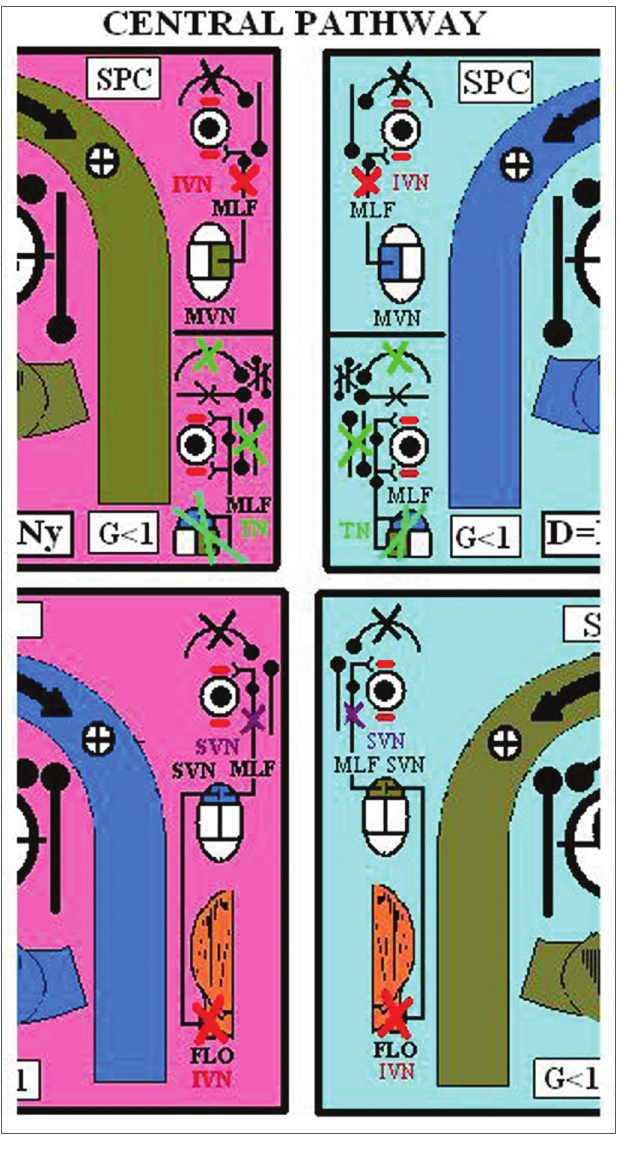
Figure 4. Central Pathway - Acronyms of figure 3: FLO: Cerebellar Floc- culus, SVN: Superior Vestibular Nuclei, MVN: Medial Vestibular Nuclei, MLF: Medial Longitudinal Fasciculus, UBN: Up Beat Nystagmus (violet), NVI: Down Beat Nystagmus (red), NT: Torsional Nystagmus